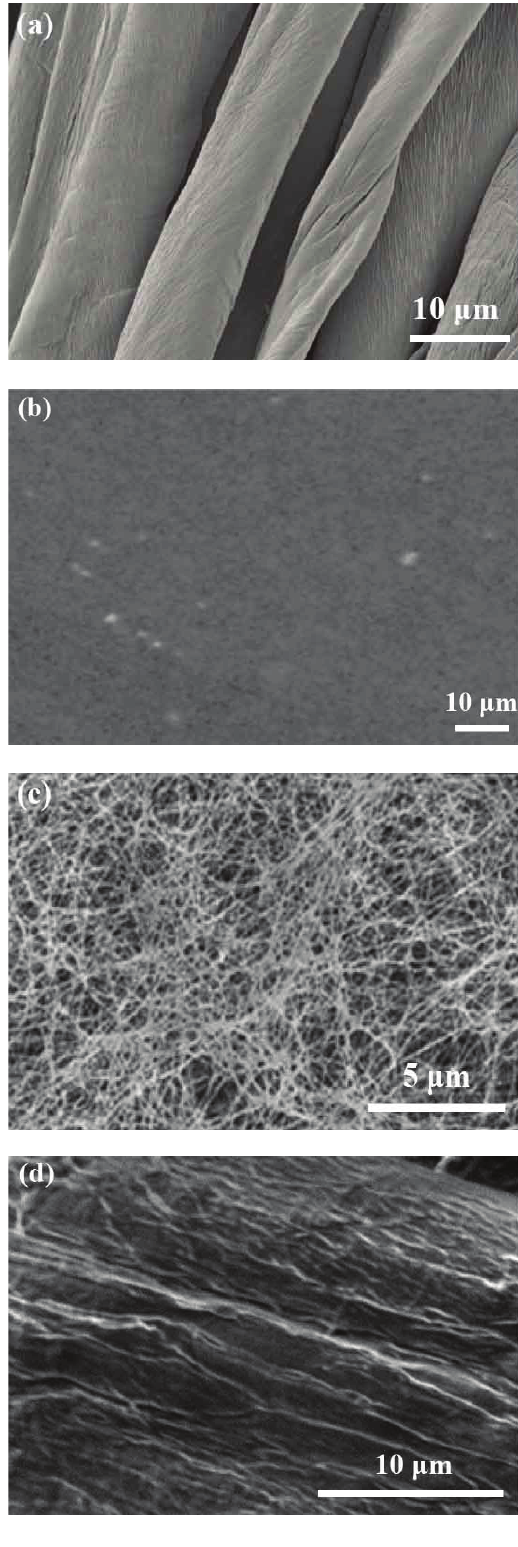
Figure 1: The SEM of cellulose a: pristine bandage fabric [74]; b: plain cellulose acetate [75]; c: pristine bacterial cellulose [72]; d: bleached softwood cellulose fibers